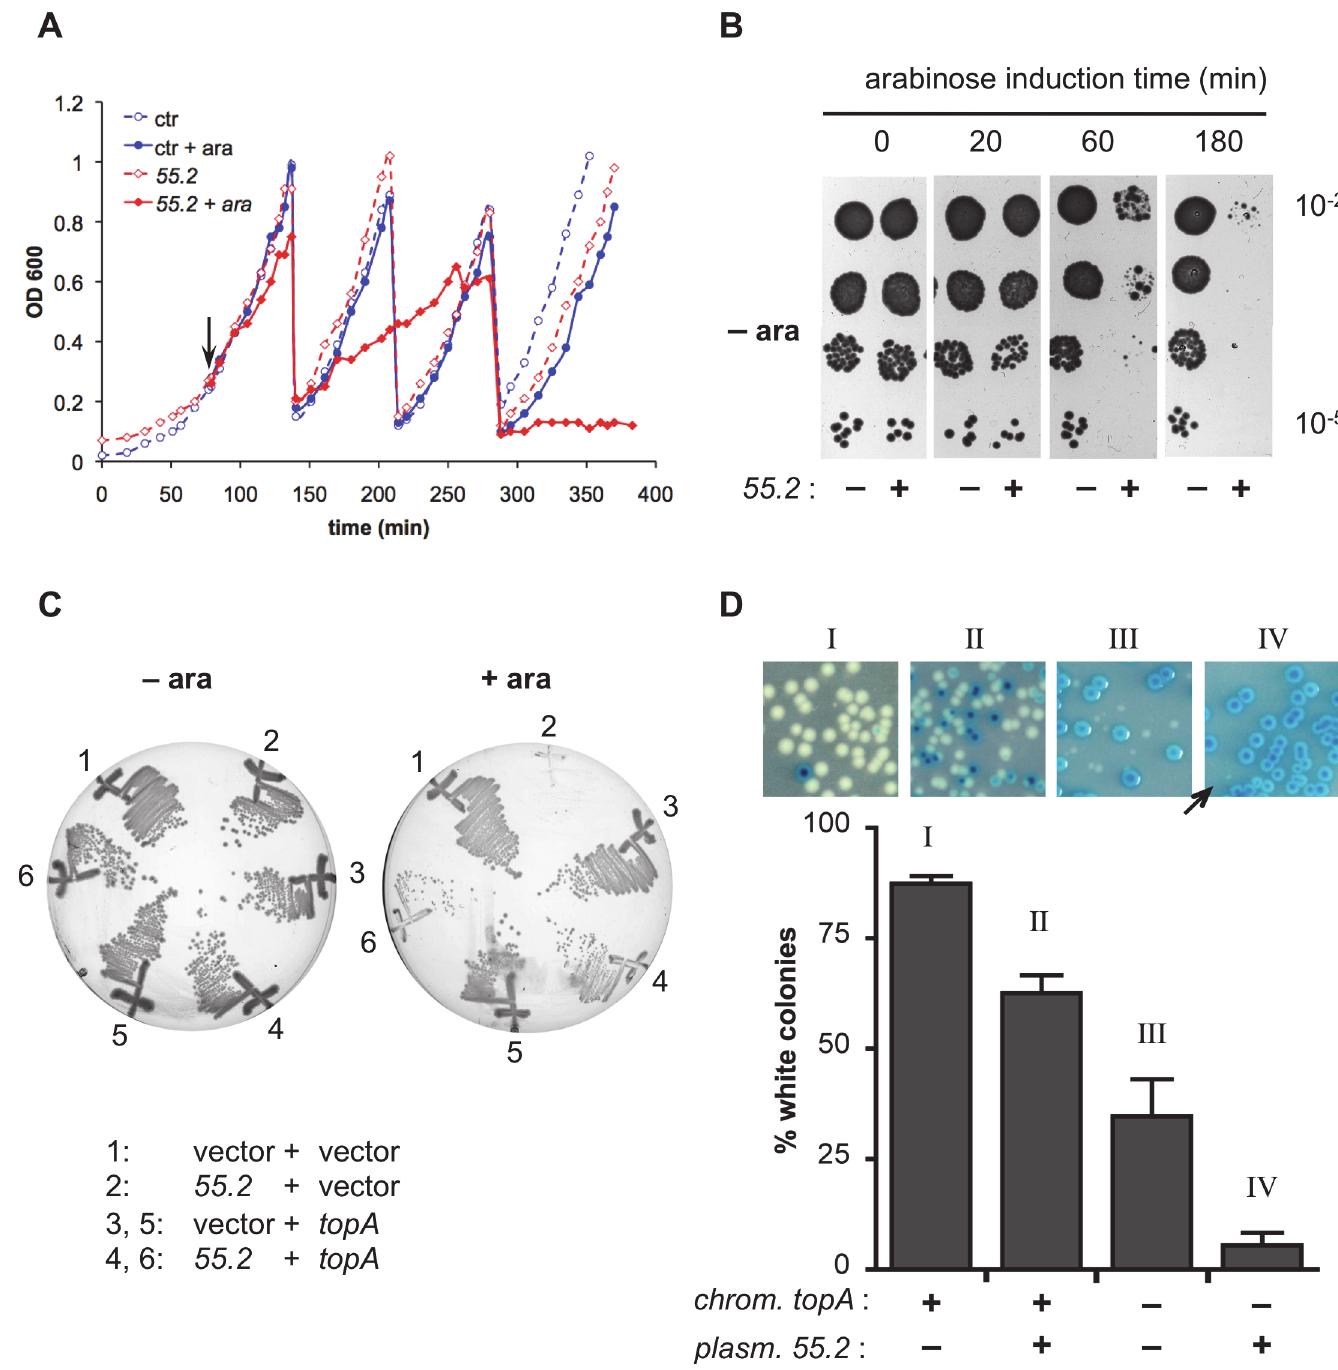
Fig 1. The toxicity of 55 . 2 in E . coli is suppressed by an increase in the copy number of topA . (A) Liquid growth assay. Overnight cultures of DB503 cells harboring pBAD101 (ctr) or pDB2114-101 ( 55 . 2 ) plasmids were diluted in fresh LB medium and optical density (A 600nm ) was measured at the indicated times. At A 600nm = 0.3, cultures were split in two and one half was induced with 0.2% arabinose (vertical arrow). When A 600nm reached (cid:1) 1, cultures were diluted 10-fold in prewarmed medium plus or minus arabinose. The graph depicts the data of a representative experiment. (B) Reversibility assay. During a growth curve assay, aliquots of arabinose-induced DB503 cultures, harboring pBAD101 ( 55 . 2 – ) or pDB2114-101 ( 55 . 2 +) plasmids, were withdrawn at the indicated times, washed in cold media without arabinose, and adjusted to the same A 600nm . Serial 10-fold dilutions were spotted on LB plates without arabinose. (C) DB503 cells transformed with pBAD101 (vector) or pDB2114-101 ( 55 . 2 ) and one of the compatible plasmids, pDB868-2 (vector, 1 – 2), pDB34- 8-4 ( topA , 3 – 4), or pDB34-8 ( topA , 5 – 6) were streaked on LB plates with or without 0.2% arabinose. (D) Plasmid based lethality assay. Overnight cultures of AS1047 ( topA +) or AS1050 ( topA -) transformed with pBAD33-K ( 55 . 2 – ) or pDB2114-33-K ( 55 . 2 +) were diluted and outgrown as indicated in the Materials